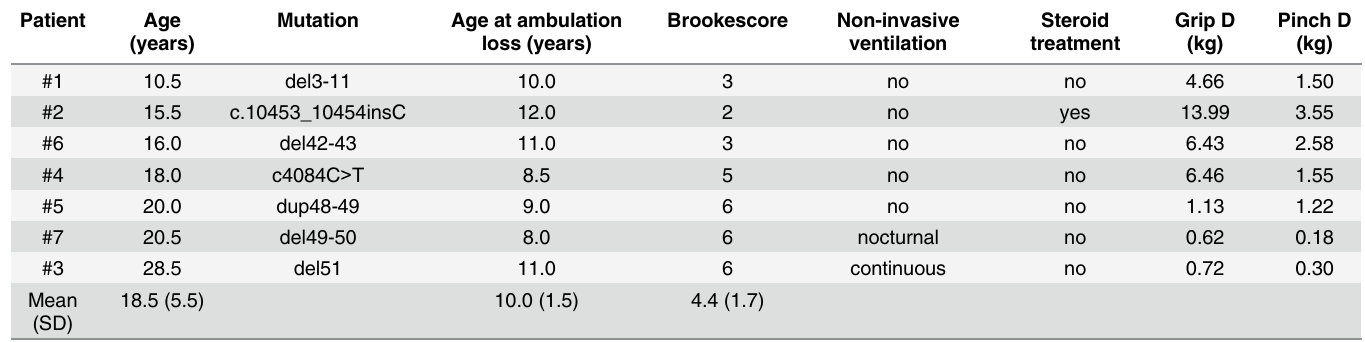
Table 1. Clinical features of the DMD patients ordered by increasing age. Patient